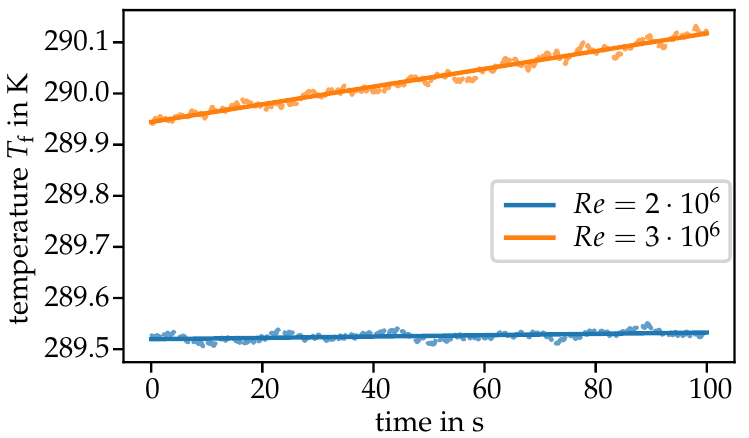
Figure 5. Linear regression of the averaged profile surface temperature over the measurement period for Re = 2 · 10 6 and Re = 3 · 10 6 . The small-scale oscillations of the surface temperature are visible by dashed